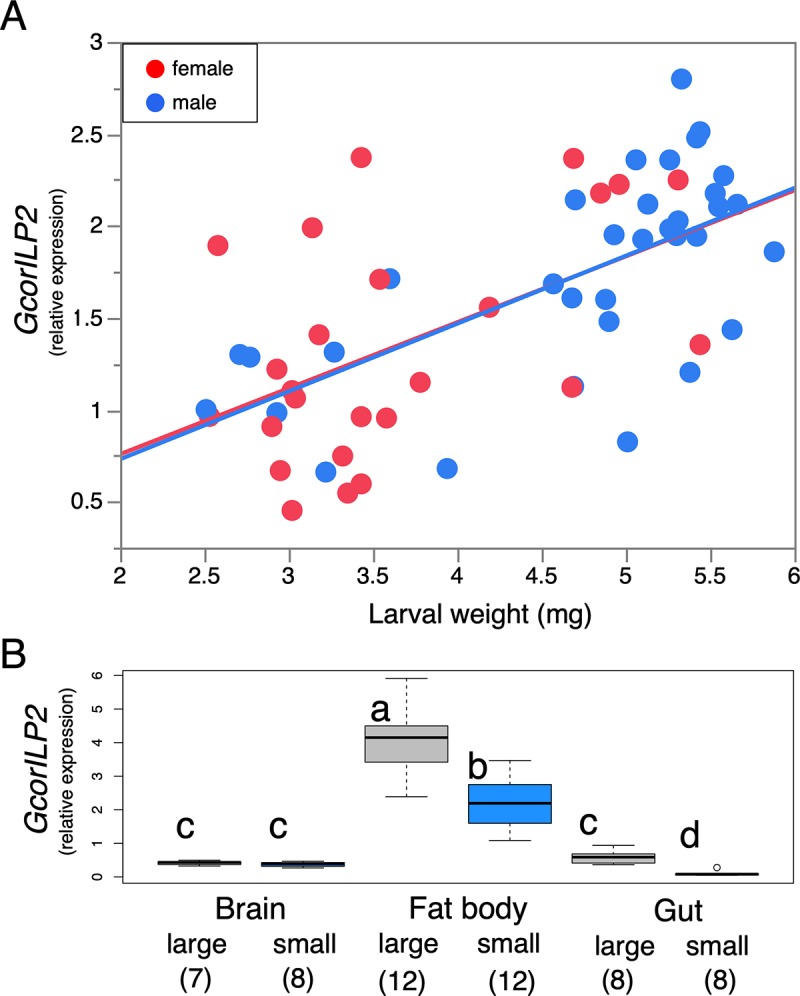
Levels of GcorILP2 transcription in the fat body of larvae.(A) Both males (blue) and females (red) exhibited body size–dependent ILP2 expression (regression analysis, female, Y = 0.359X + 0.040, R2 = 0.25, p = 0.01; male, Y = 0.369X − 0.006, R2 = 0.42, p < 0.0001). n = 25 and 34 for females and males, respectively. (B) GcorILP2 was specific to the fat body and more abundant in large larvae. Different letters indicate significant differences (Steel-Dwass test). Gray (left): large; blue (right): small. Day-2 larvae were subjected to analysis. Gene expression levels relative to Gcorgapdh were quantified by qPCR. The underlying data in this figure are available from figshare (DOI: 10.6084/m9.figshare.9734780; https://figshare.com/s/609486022a3df39169bf). Gcorgapdh, G. cornutus glyceraldehyde 3-phosphate dehydrogenase; GcorILP2, G. cornutus ILP2; ILP2, insulin-like peptide 2; qPCR, quantitative PCR.